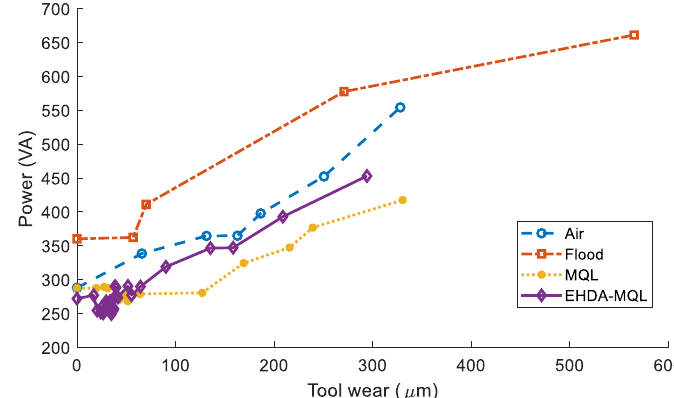
Figure 7. Power consumption against tool wear for various cooling-lubrication methods.